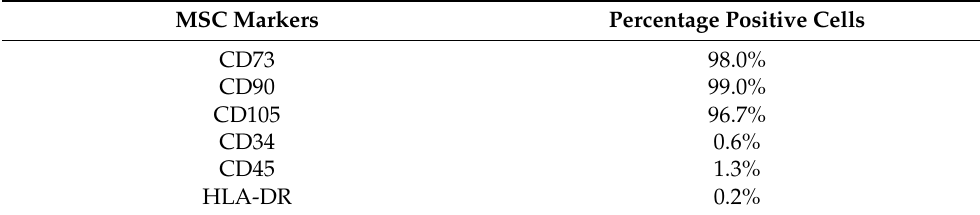
Table 2. Flow cytometry analysis of MSC-specific markers in DPSCs.